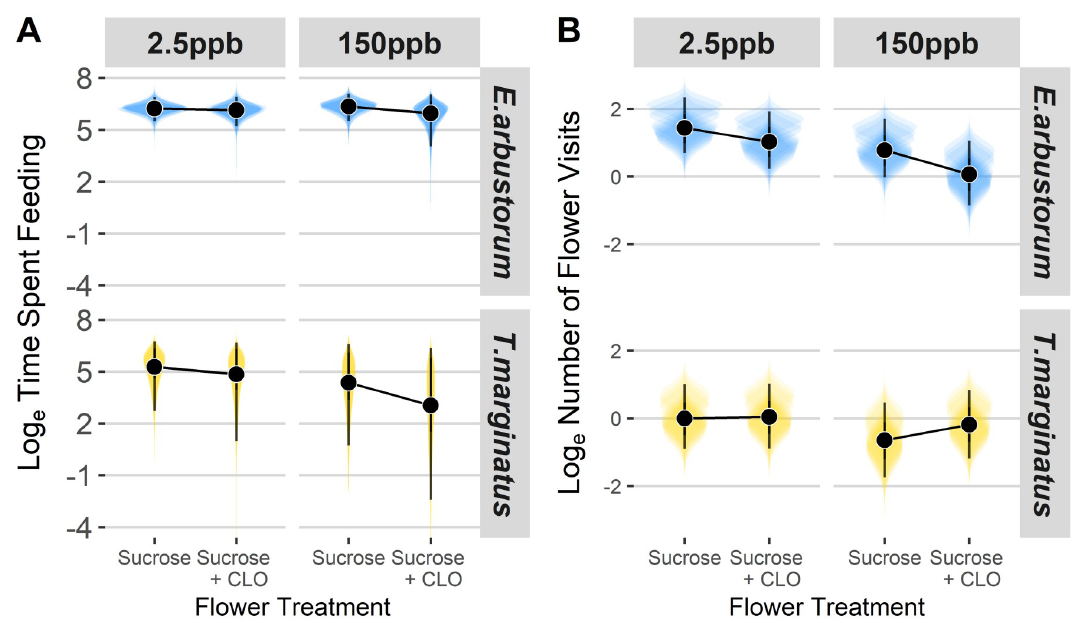
Fig 1. Hover fly time spent feeding and number of visits to sucrose only vs. sucrose + clothianidian (CLO) treated artificial flowers. Median and 95% highest posterior density intervals of (A) log e time spent feeding on sucrose only vs. sucrose + clothianidin (CLO) treated artificial flowers at 2.5 ppb and 150 ppb and (B) log e number of visits to sucrose only vs. sucrose + clothianidian (CLO) treated artificial flowers at 2.5 ppb and 150 ppb for Eristalis arbustorum and Toxomerus marginatus hover flies. Shaded areas respresent posterior distributions of hover flies’ responses for individual trials (n = 10